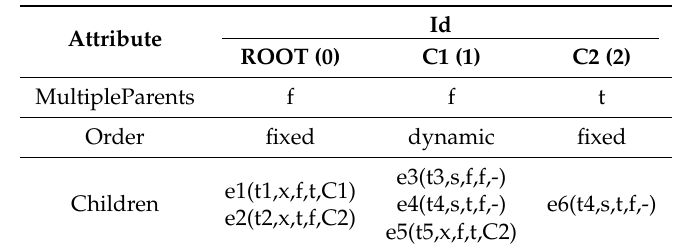
Table 1. Schema Context table example. Each column represents an eContext . The content of the Children row represents the tuple ( Template , Type , IsOptional , IsArray , Context ). x denotes complex , s string , f F ALSE and t T RUE